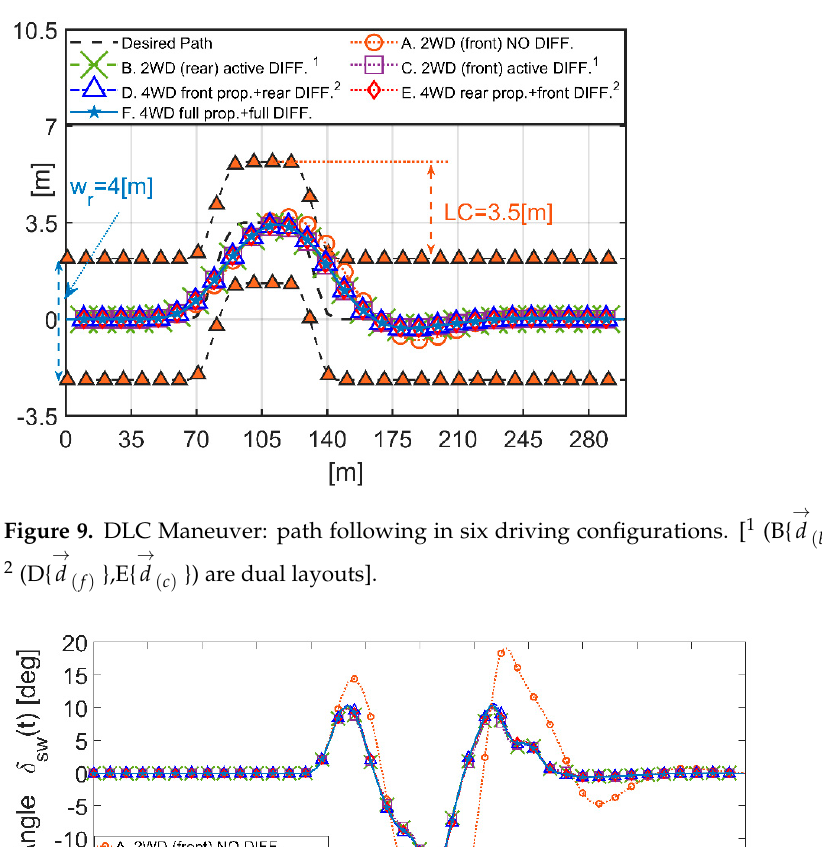
A. 2WD (front) NO DIFF.{ 𝑑⃗ ((cid:3032)) }; B. 2WD (rear) active DIFF.{ 𝑑⃗ ((cid:3029)) }; C. 2WD (front) active DIFF. { 𝑑⃗ ((cid:3034)) }; D. 4WD front prop.+rear DIFF. { 𝑑⃗ ((cid:3033)) }; E. 4WD rear prop.+front DIFF. { 𝑑⃗ ((cid:3030)) }; F. 4WD full prop.+full DIFF.{ 𝑑⃗ ((cid:3039)) }. The vehicle is cruising at 120 [km/h] on wet asphalt (fric-